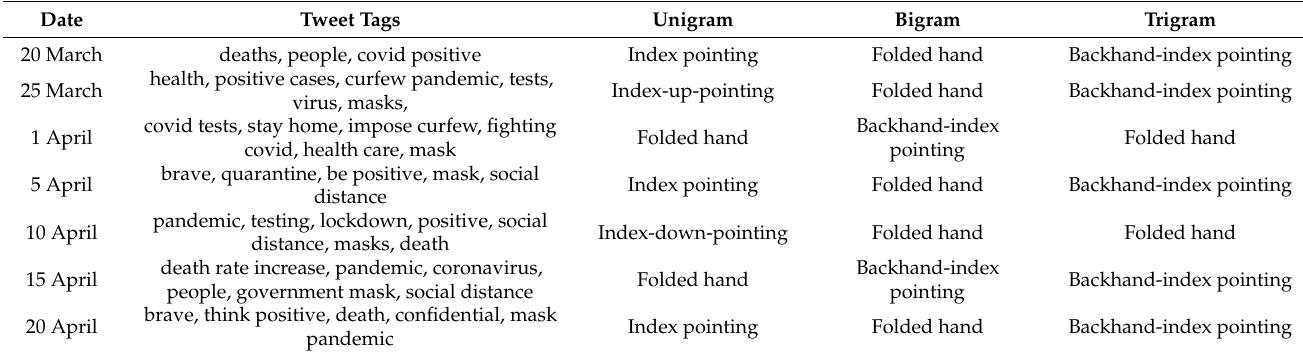
Table 3. Emojis shared via